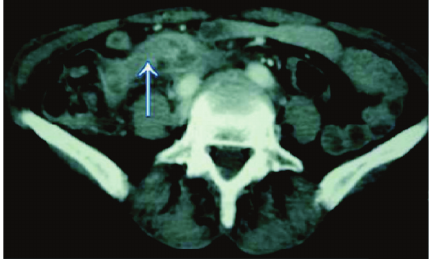
Figure 3: Tumefied appendice with local infiltra.